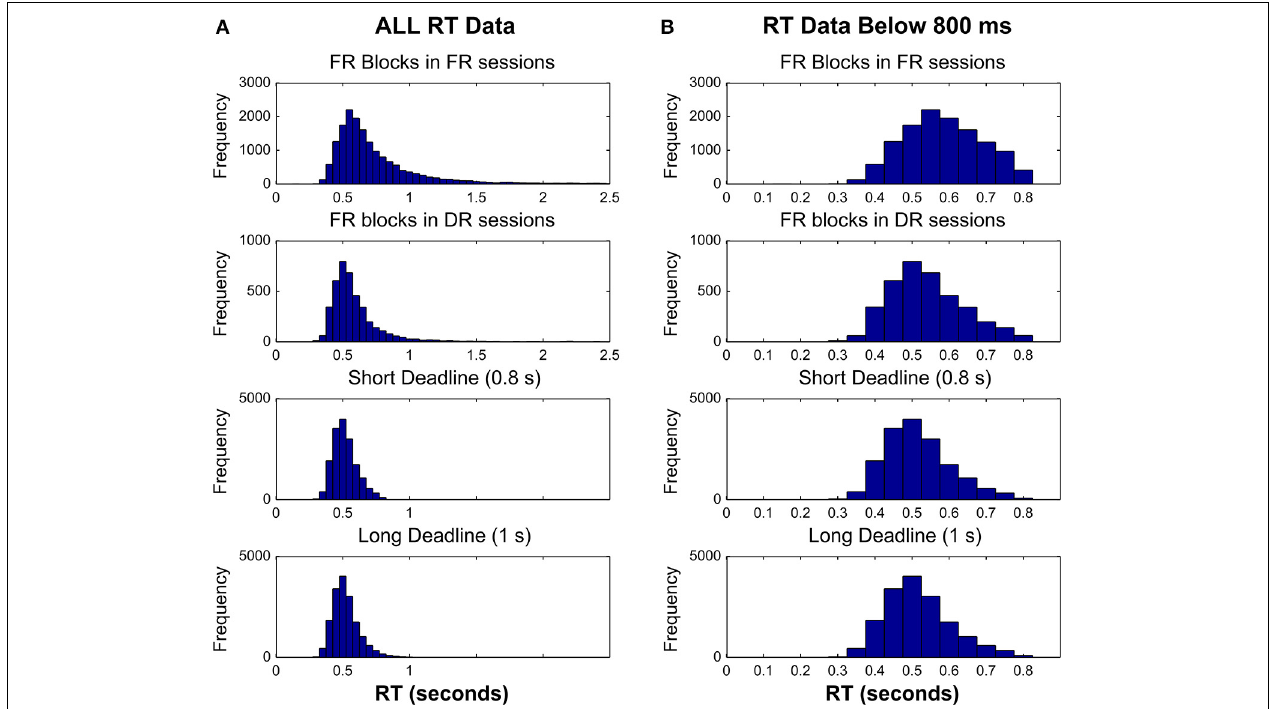
FIGURE 7 | Response time distributions for FR blocks in FR sessions, FR blocks in DR sessions, Short DR blocks in DR sessions and Long DL blocks in DR sessions. RT data pooled across participants are plotted either (A) without an upper limit, or (B) with an upper limit of the short deadline duration